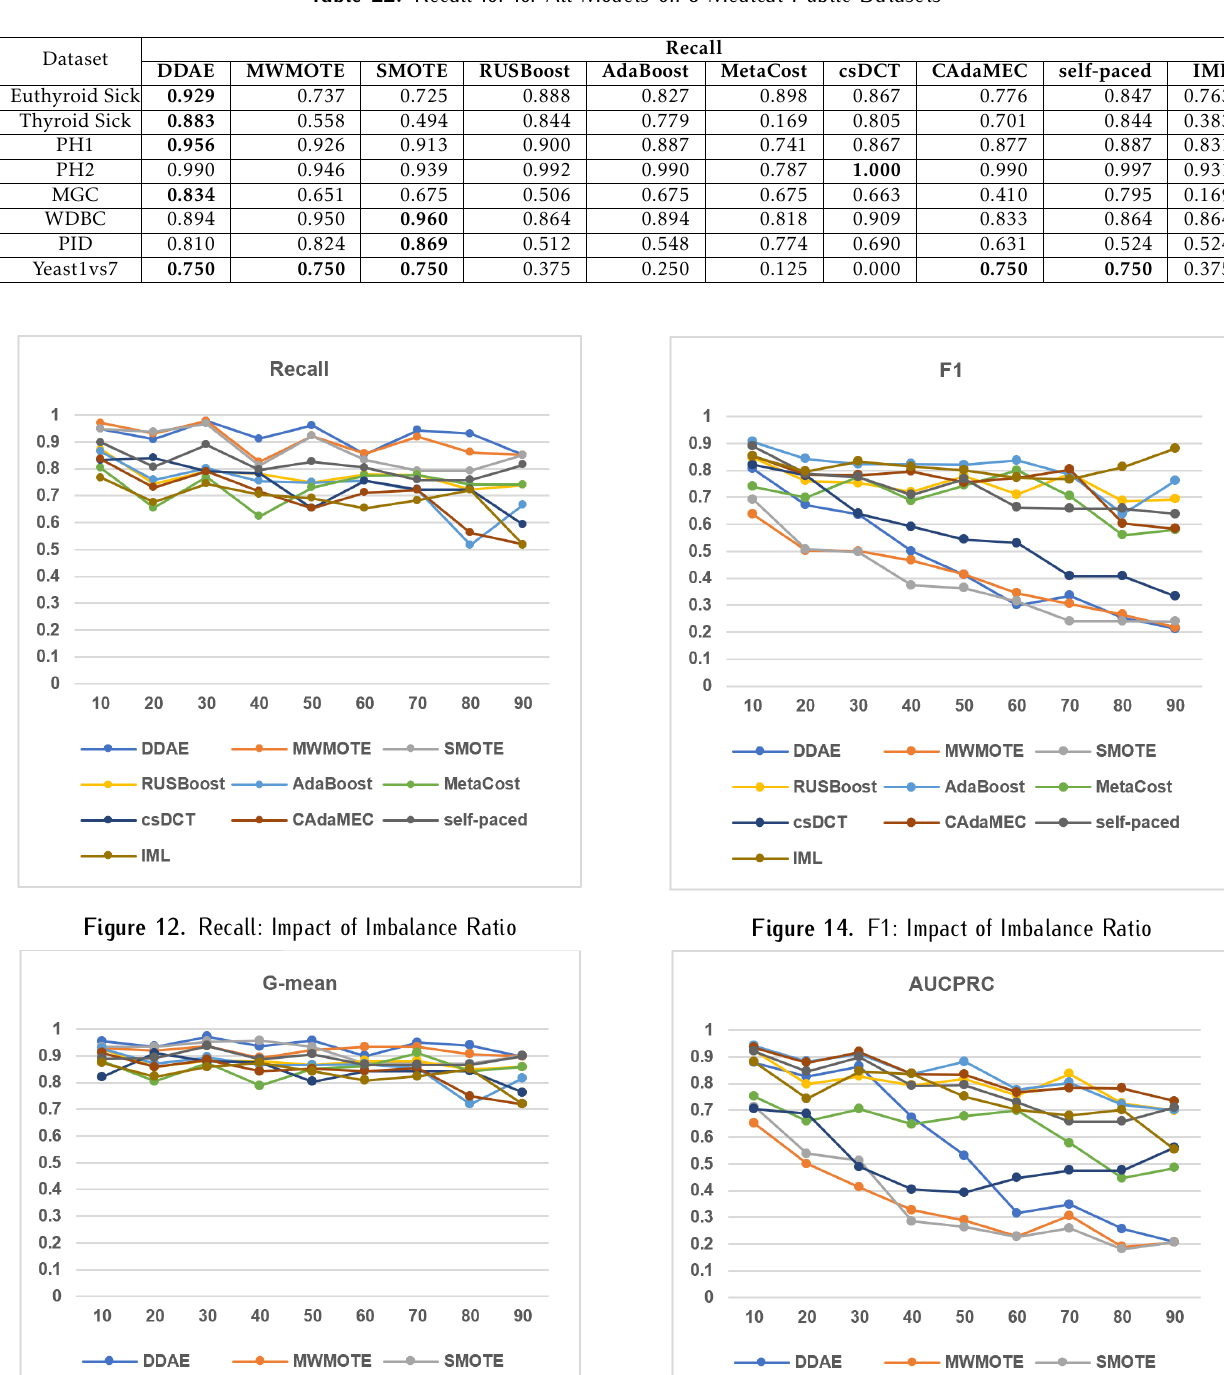
Figure 15. AUCPRC: Impact of Imbalance Ratio